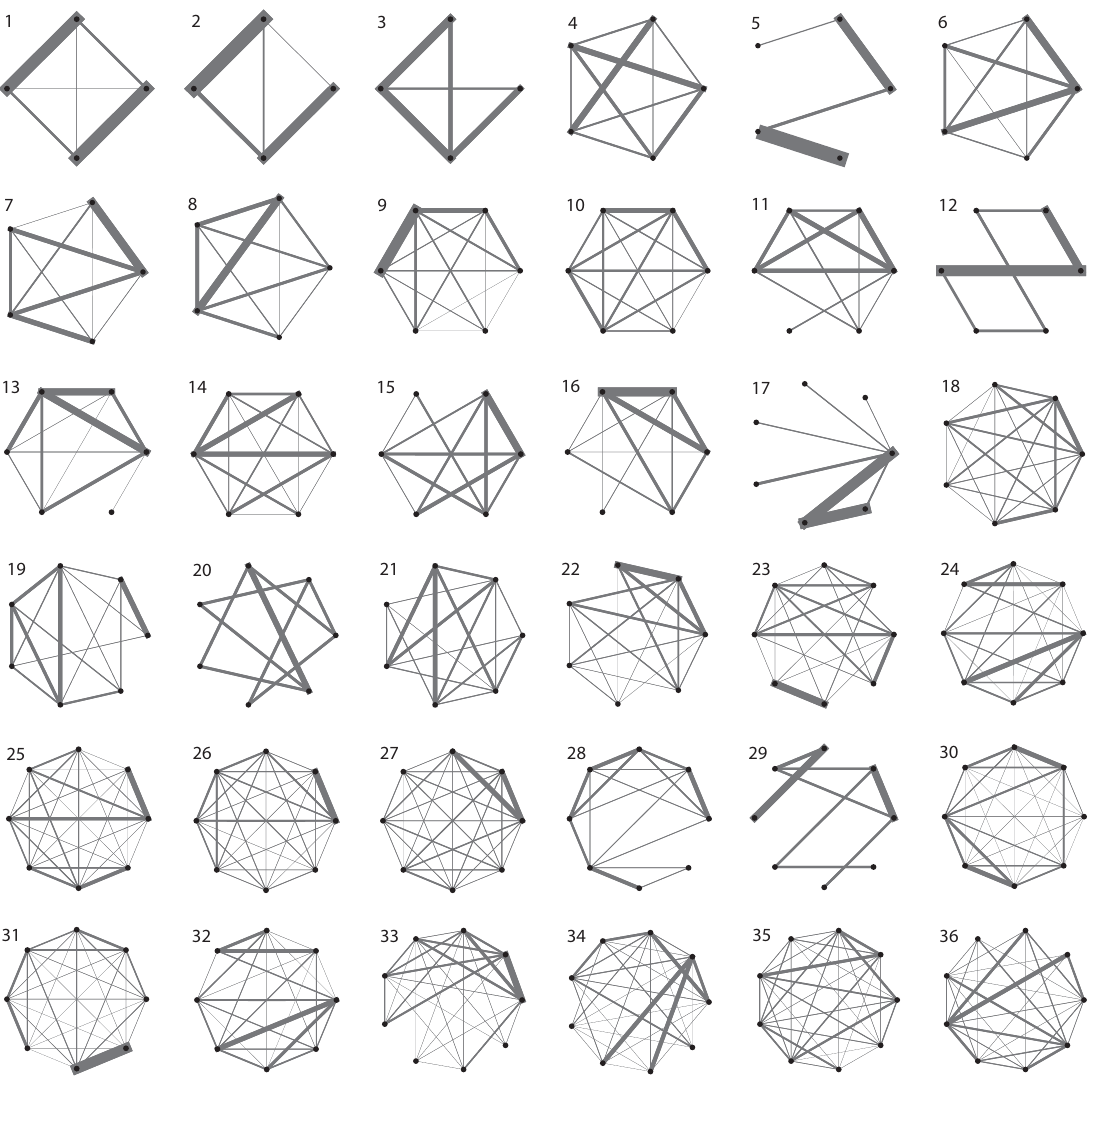
Figure 1. Graphs based on primate grooming networks. Edges denote grooming interactions between individuals; edge weights indicate interaction frequencies. Grooming networks from: Macaca arctoides (68,6,7,72,37) , fuscata (54,17,46,47,74,55,57,31,73,65) , fascicularis (24,40,70,32,44) , radiata (62,75) , mulatta (63) , tonkeana (76) , assamensis (71) , sylvanus (52,22,61) , Cercopithecus neglectus (9) , campbelli (59) , mitis (64,67) , Chlorocebus aethiops (26,18,27,78,19,21,45) , Cercocebus torquatus (81) , Miopithecus talapoin (25) , Erythrocebus patas (69,30) , Trachypithecus pileatus (53) , Presbytis entellus (56,42) , Colobus guereza (8) , Papio anubis (80) , papio (34,77,79) , cynocephalus (28) , Theropithecus gelada (12) , Mandrillus sphinx (5) , Piliocolobus tephrosceles (66) , Pan troglodytes (58,23,41,35,48,43,36) , paniscus (42) , Cebus apella (51,15,16,50) , capucinus (10) , olivaceus (33) , Callithrix jacchus (3,11,29) , Alouatta caraya (4) , fusca. (13) , palliata (49,20) , Ateles geoffroyi (60,38,39) , Eulemur macaco